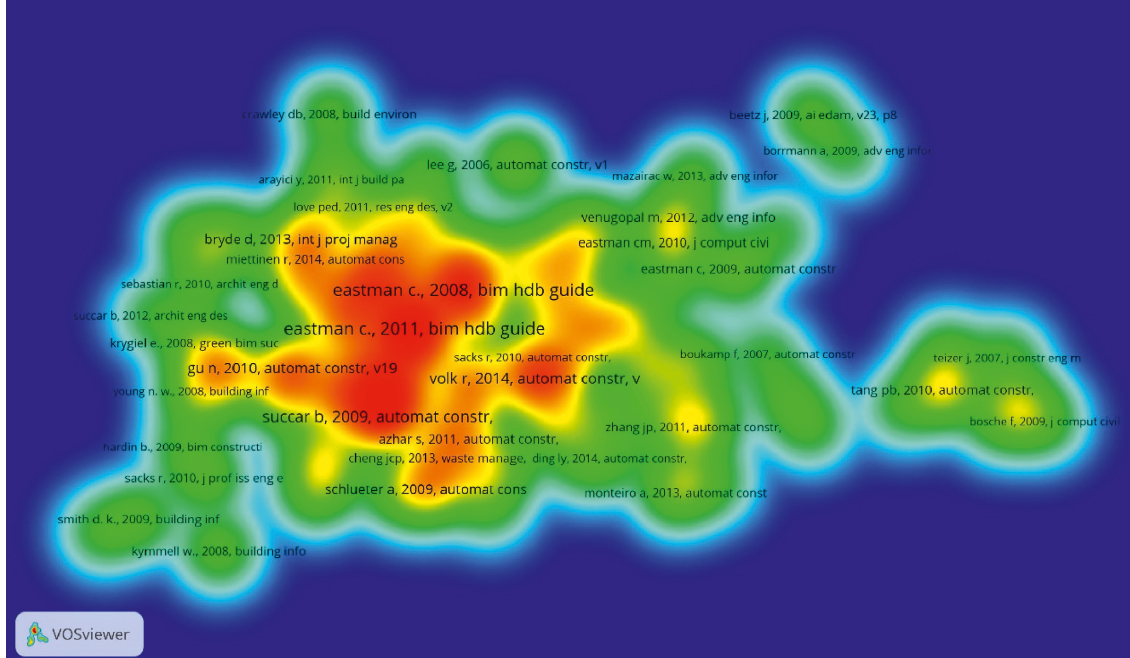
Figure 2: Most influential studies in BIM field: